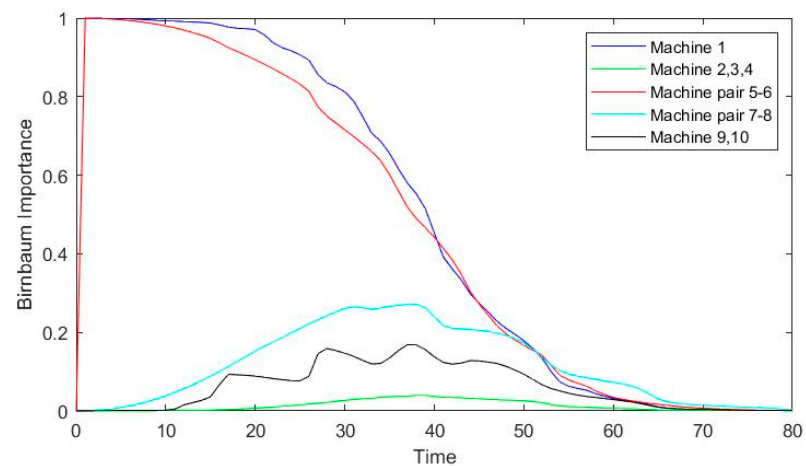
Figure 13. Machine Birnbaum importance (Case 2).